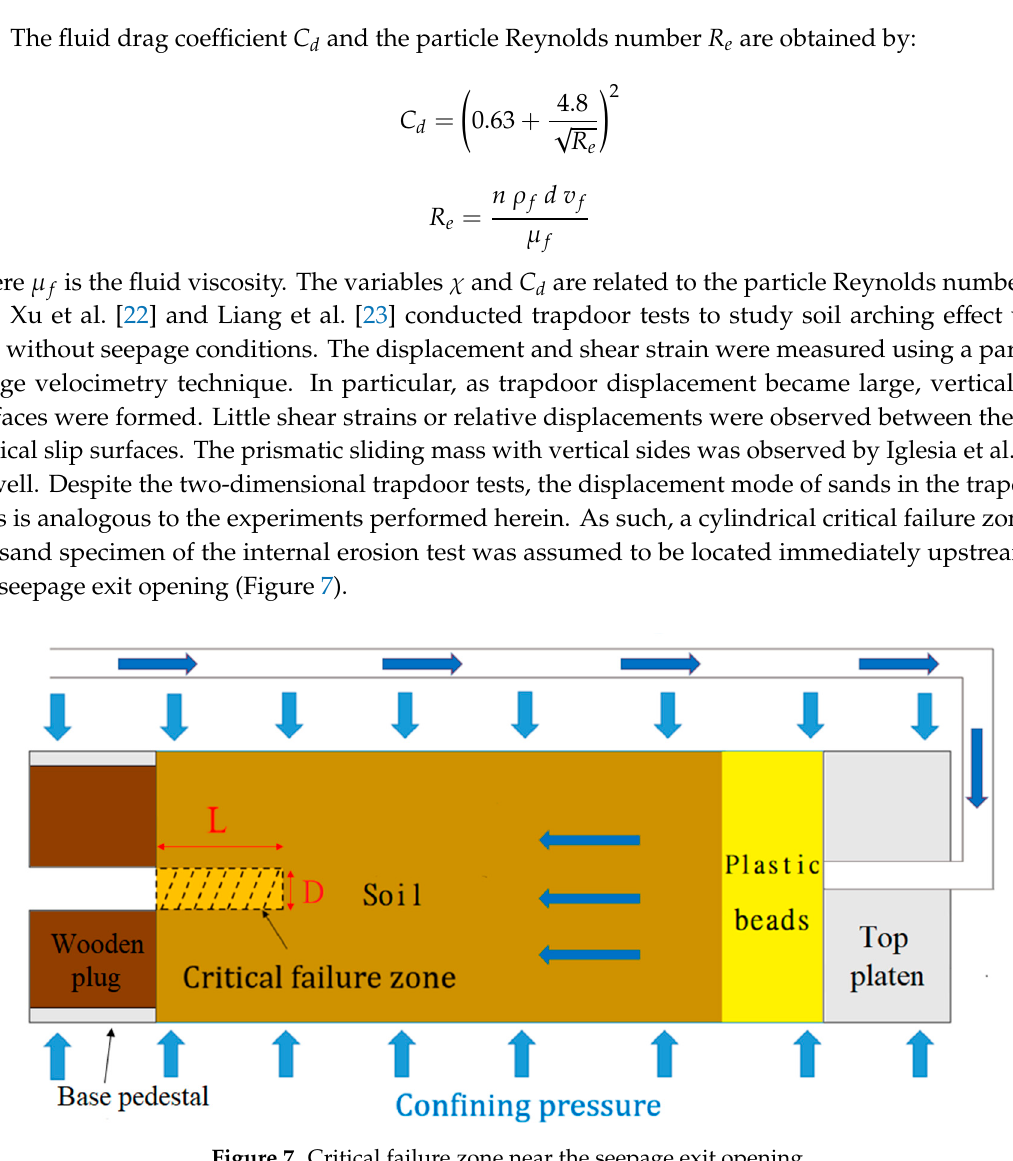
Figure 7. Critical failure zone near the seepage exit opening.